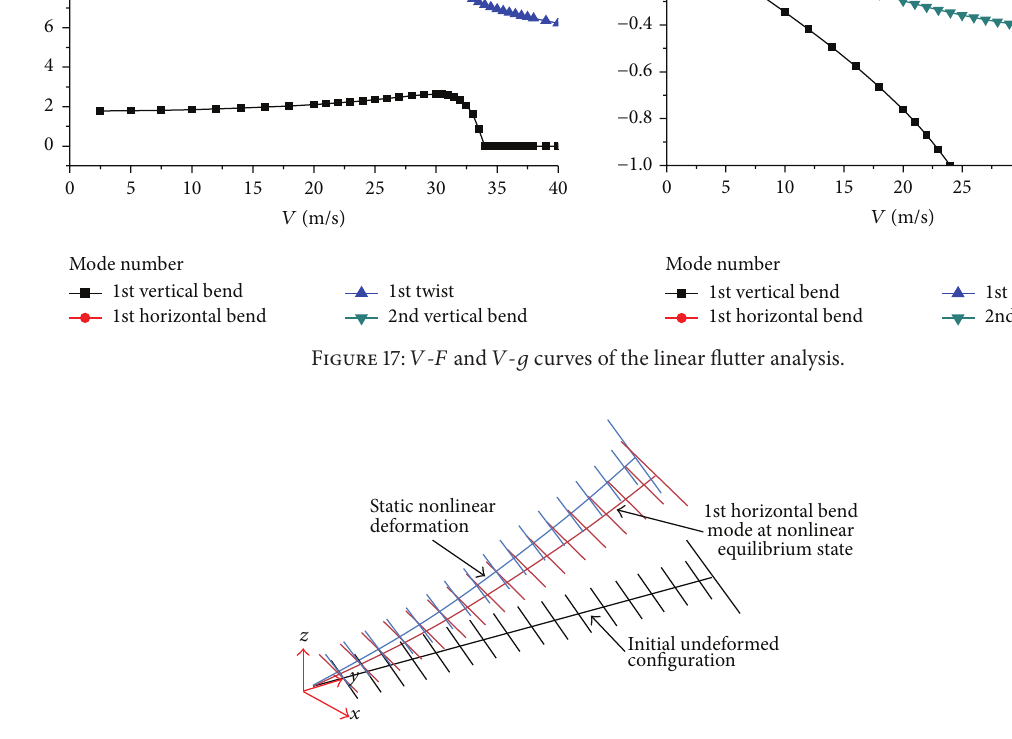
Figure 18: Horizontal bending mode in a nonlinear equilibrium